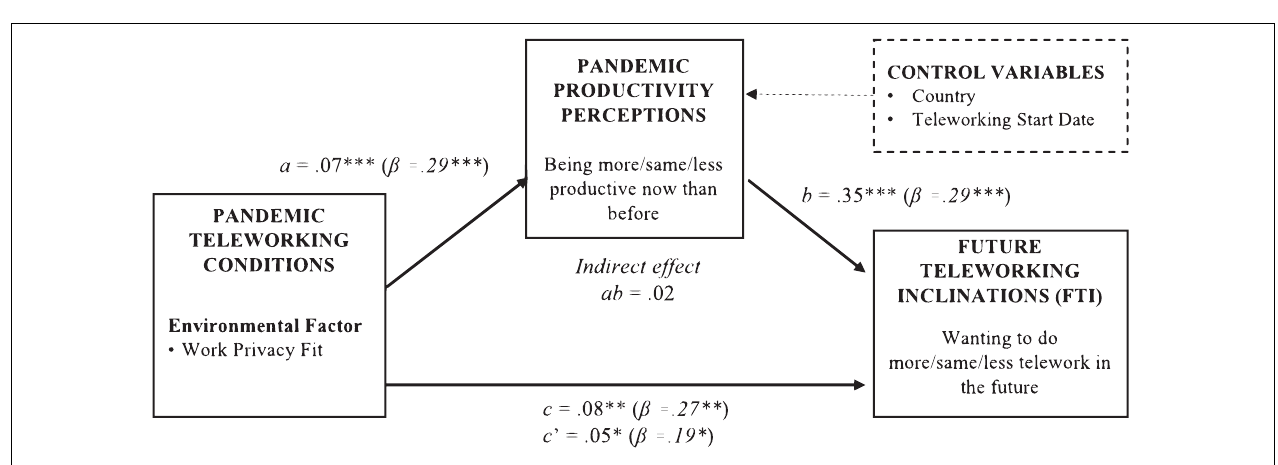
FIGURE 4 | Supported hypothesised relationships. ∗ p < 0.05; ∗∗ p < 0.01; n =184. Non-significant predictors of FTI were job control ( p = 0 12), job change ( p = 0.30), home office adequacy (ergonomic adequacy, p = 0.14; technical equipment, p = 0.52; data/document access, p = 0.033) and childcare responsibilities ( p =